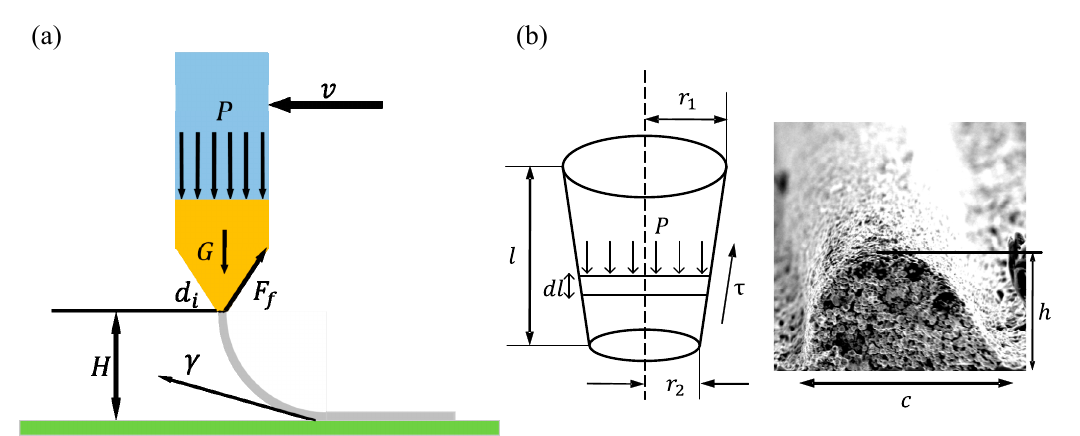
Figure 1. ( a ) The print force analysis diagram of the model. ( b ) A simplified model of the print head and the morphology change of the conductive paste.